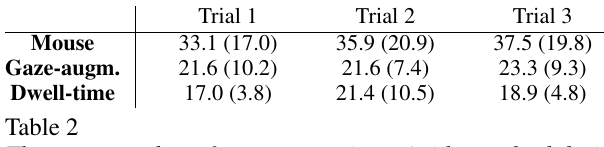
The mean number of moves per minute (with standard devi- ation) during the three